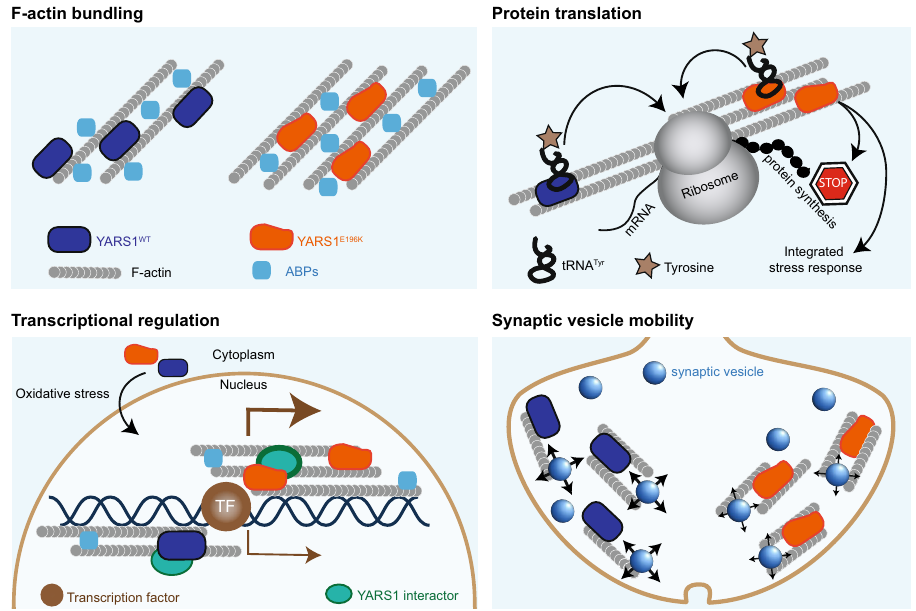
Fig. 7 | Illustration of the known cellular processes implicated in YARS1 CMT . The enhanced F-actin bundling properties described for YARS1 CMT in this study might contribute to global protein synthesis inhibition, activation of the integrated stress response, transcriptional disregulation, and impaired synaptic vesicle